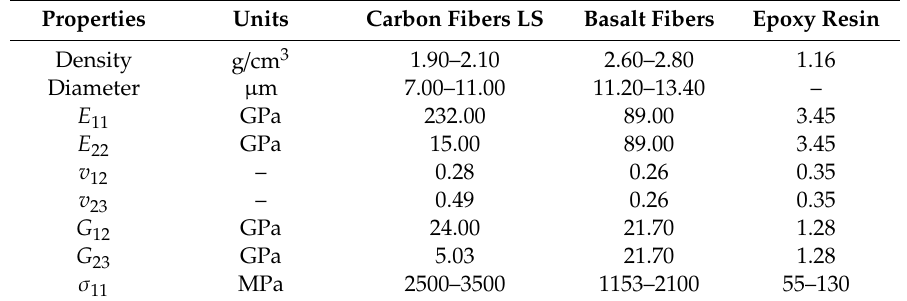
Table 1. Properties of constituents utilized for preparing Hybrid Fiber Reinforced Polymers (HFRP) rebars [34].